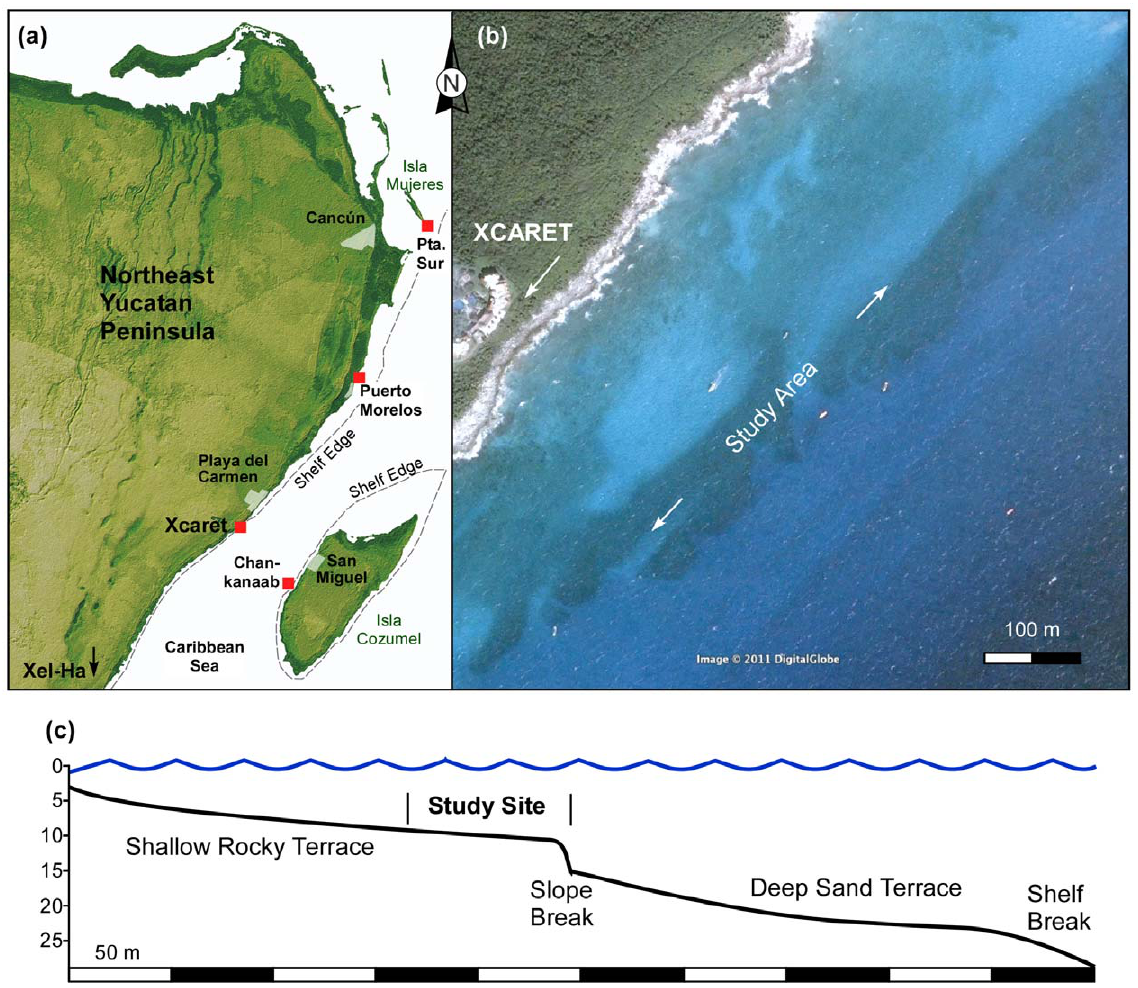
Figure 2. Location of the study site (a) and depth profile and zonation (b).